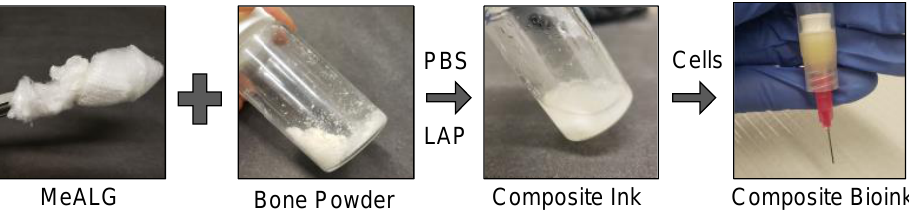
Figure 1. Preparation of composite bioinks. Pictures showing MeALG, bone powder, and composite ink solution in PBS containing photoinitiator (LAP). After addition of hMSCs, composite bioink is transferred into a syringe for bioprinting.